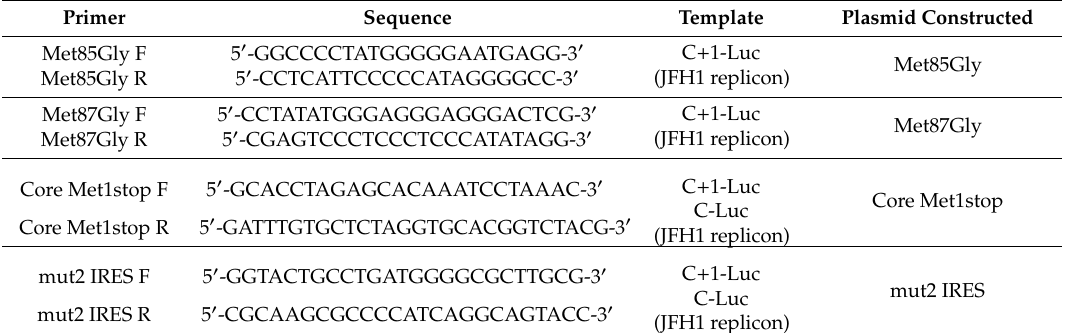
Table 2. List of priming specific oligonucleotides and plasmid DNA templates used for site-directed mutagenesis (mutated nucleotides are shown in